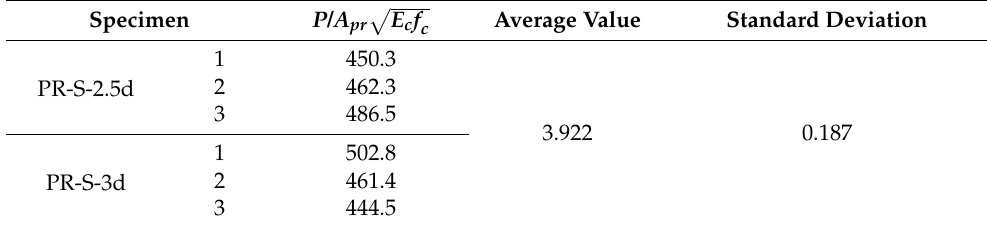
Table 7. Ultimate strength of specimens with aspect ratio larger than 2.5.